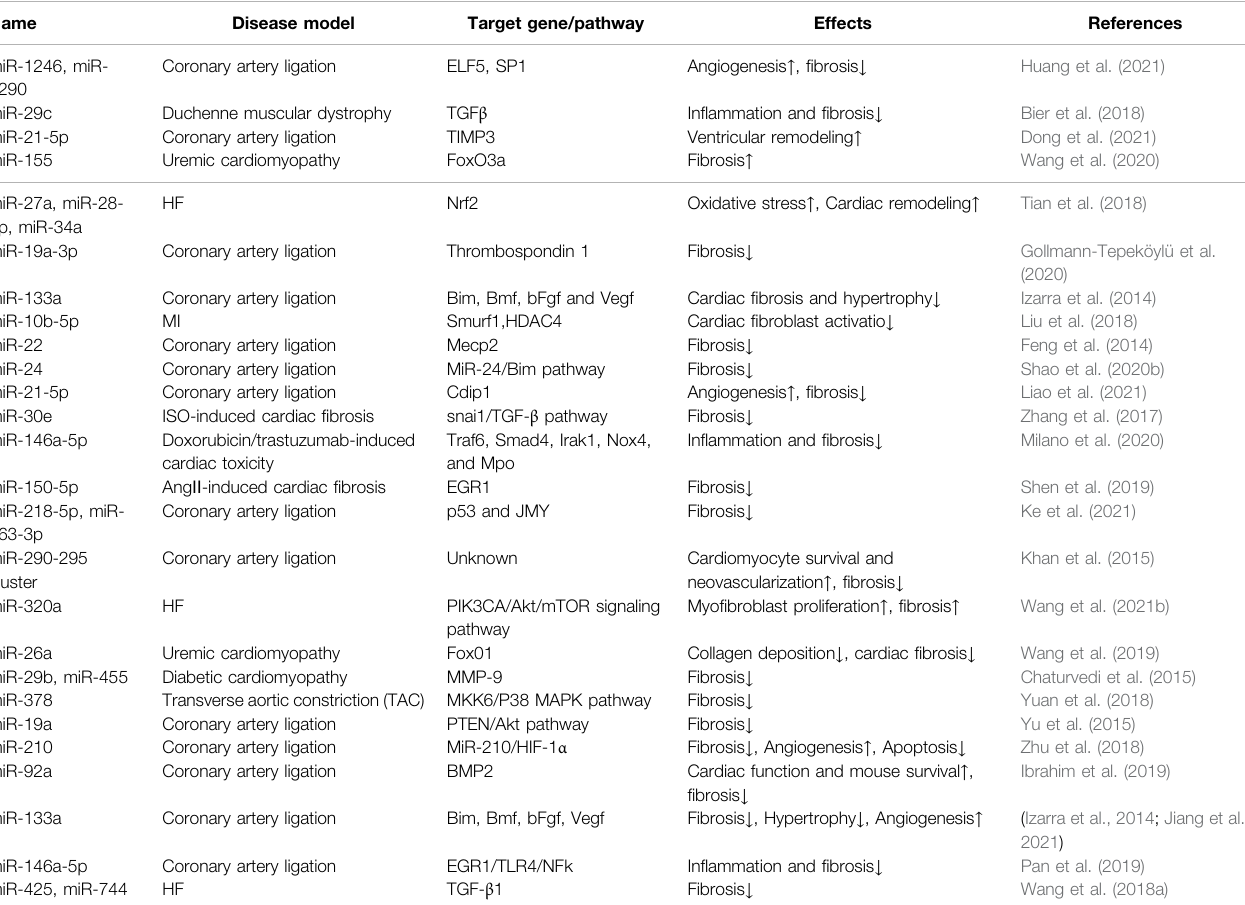
TABLE 1 | Exosomal miRNAs